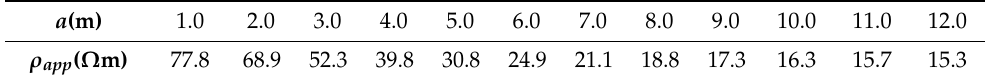
Table 8. Apparent resistivity profile data vs. electrode separation a , for the site located in Cas- telldefels.